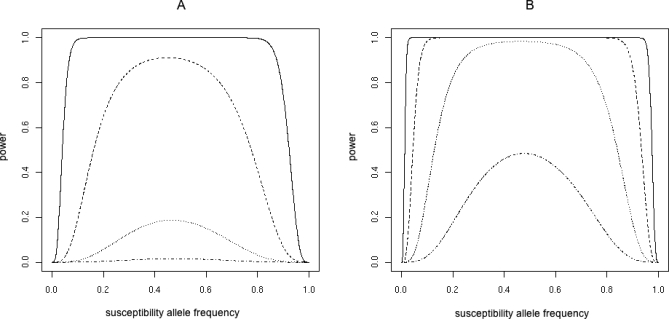
Power Calculated Using Quanto for 1,000 Cases and Controls (A) and 3,000 Cases and Controls (B)Lines are for GRR = 2 (solid), 1.5 (dashed), 1.3 (dotted), 1.2 (dashed and dotted). A multiplicative mode of inheritance is assumed.